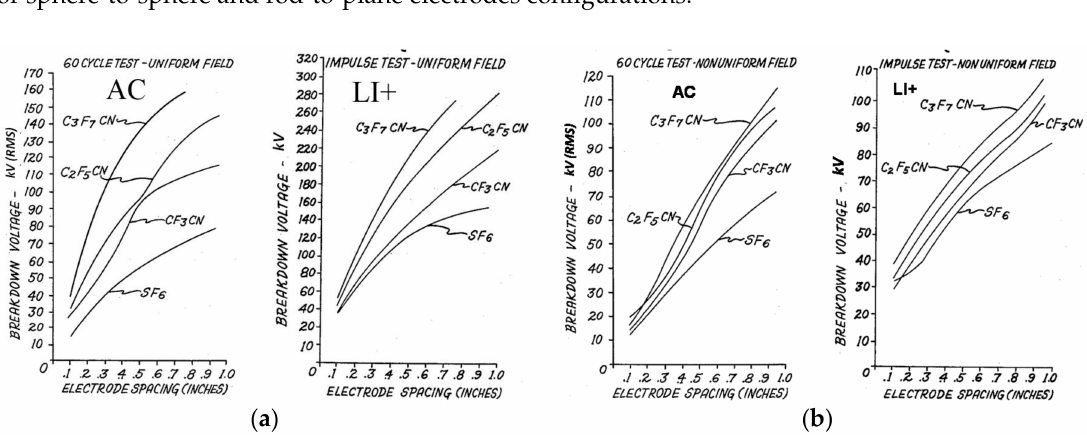
Figure 11. Dielectric performances of fluorinated nitriles [59]: ( a ) Configuration: sphere-sphere (diameter = 1 inch); ( b ) configuration: rod (d = 0.1 inch)-sphere (D = 1